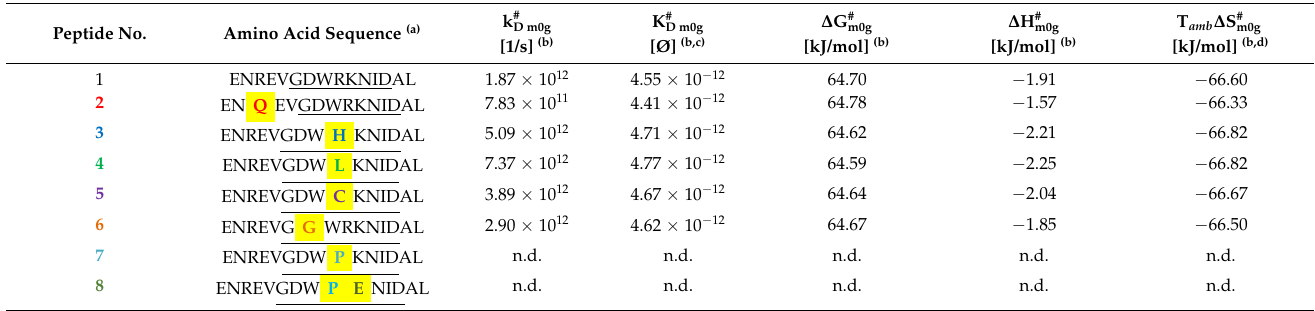
Table 3. Apparent kinetic and apparent thermodynamic values for gas-phase immune complex dissociations of hcTn I epitope peptides and anti-hcTn I